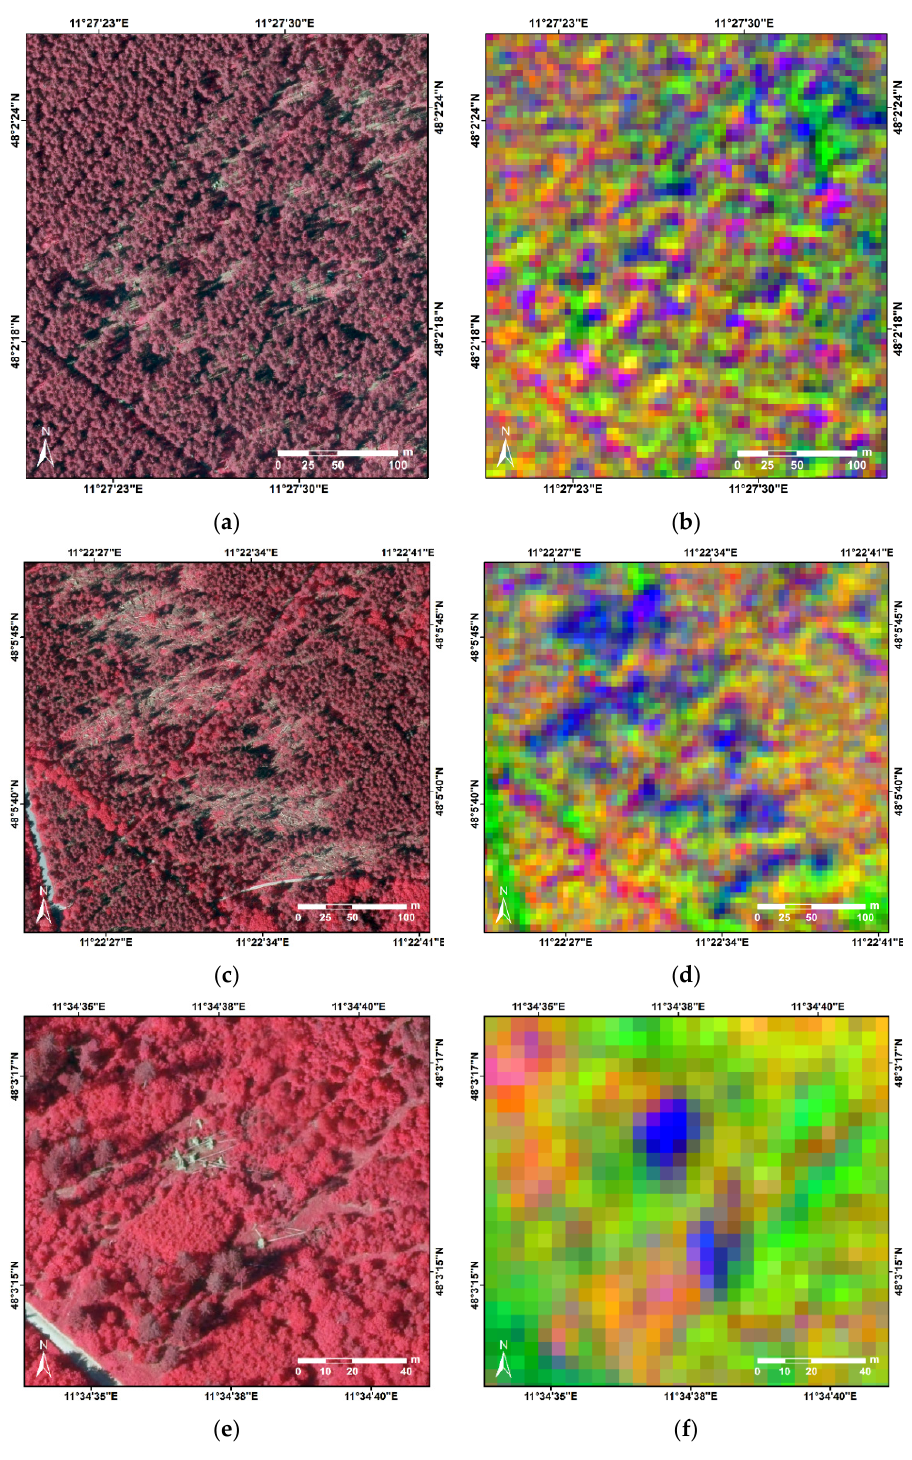
Figure 7. Examples of detected windthrow areas depicted with false color composite orthophoto (band combination: near infrared—red—green) ( a , c , e ) and pixel ‐ based result based on RapidEye data ( b , d , f ) for Munich South . Windthrow areas appear in blue. Scattered tree damage ( a – d ), the damage often occurred in recently thinned forest ( a ) where skid trails are visible. Small groups of affected trees could also be detected ( e , f ). Here small thrown stands, comprising eight (left) and three (right) trees, respectively, were detected.